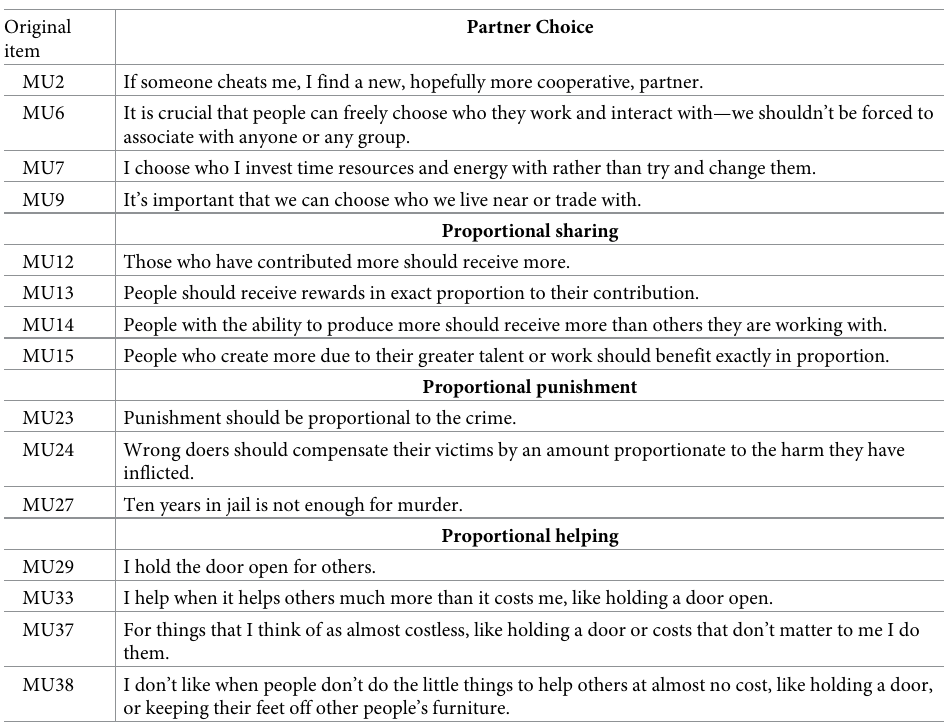
Table 1. Items of the final 15-item mutualism